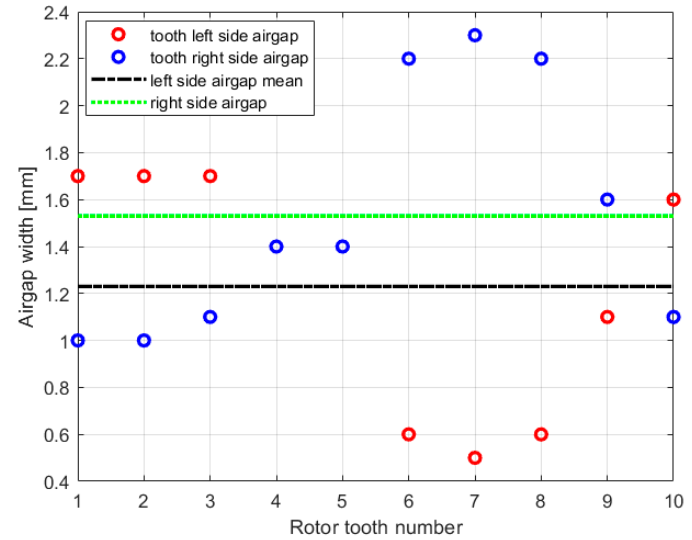
Figure 19. Airgap width values measured on the left and right sides of each rotor tooth.